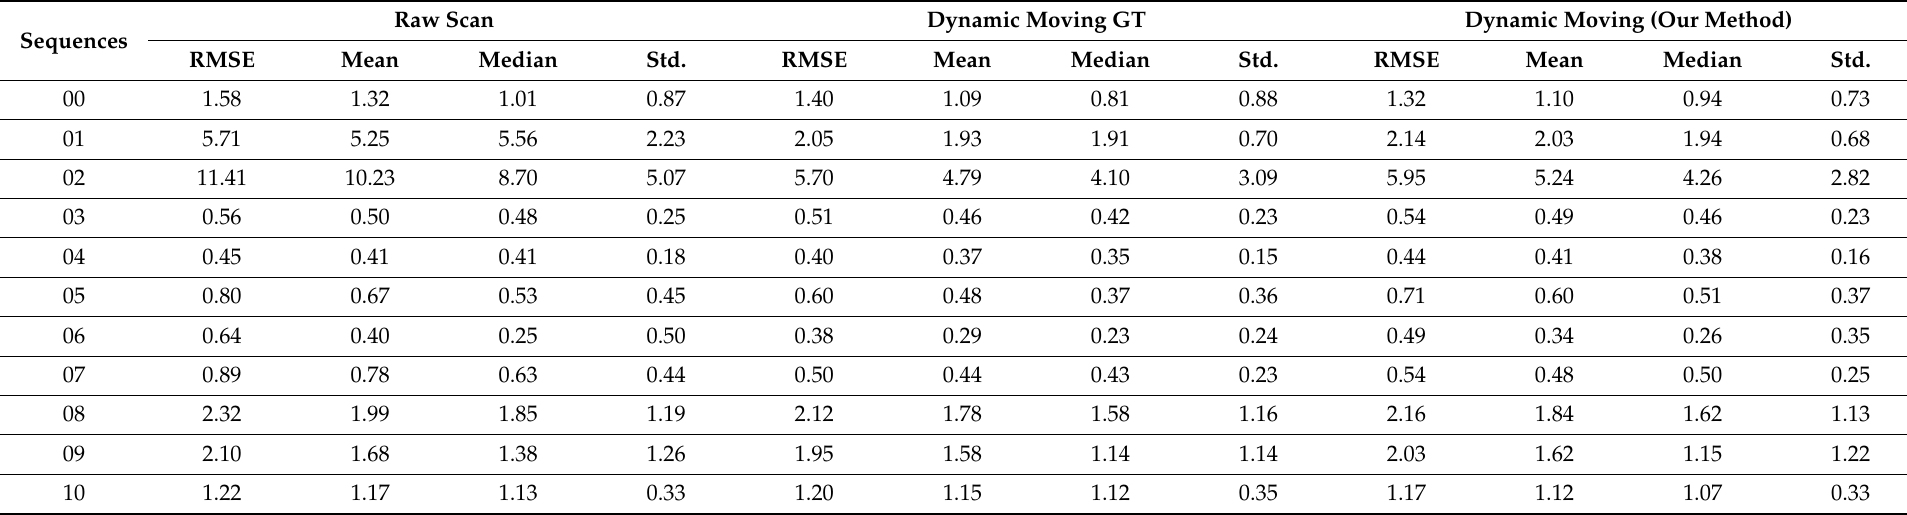
Table 7. Comparison of APE for translation part (unit: